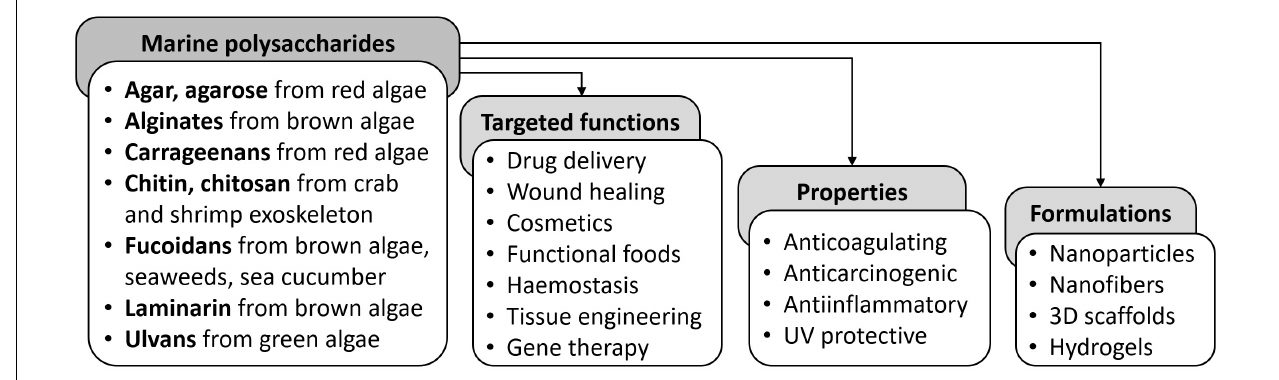
FIGURE 3 | Examples of marine polysaccharides and their applicability for biomedical purposes (Ruocco et al., 2016; Joshi et al., 2019).